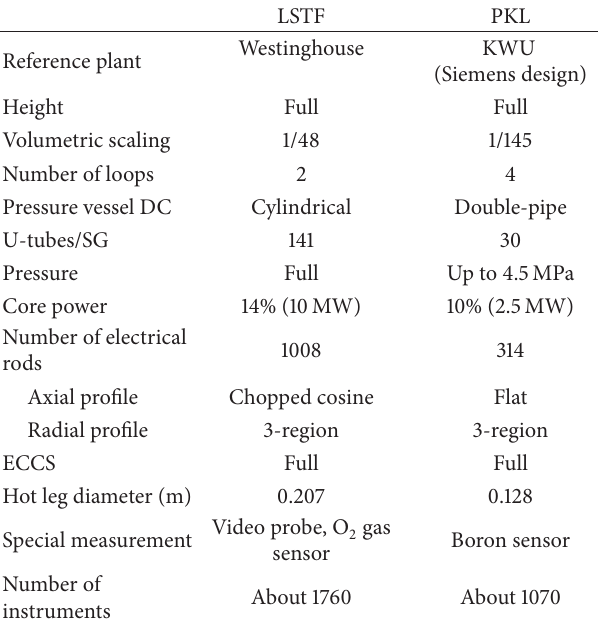
Table 1: PKL and LSTF major